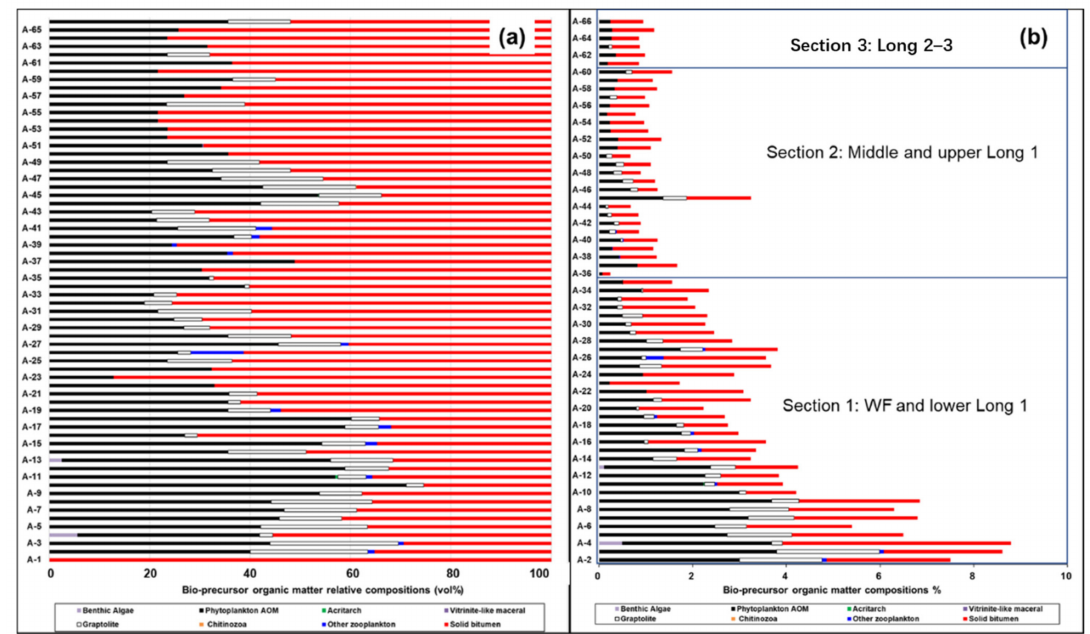
Figure 8. The relative ( a ) and quantitative ( b ) bio-precursor organic matter composition. The plots of TOC and organic matter content (OMC) measured under